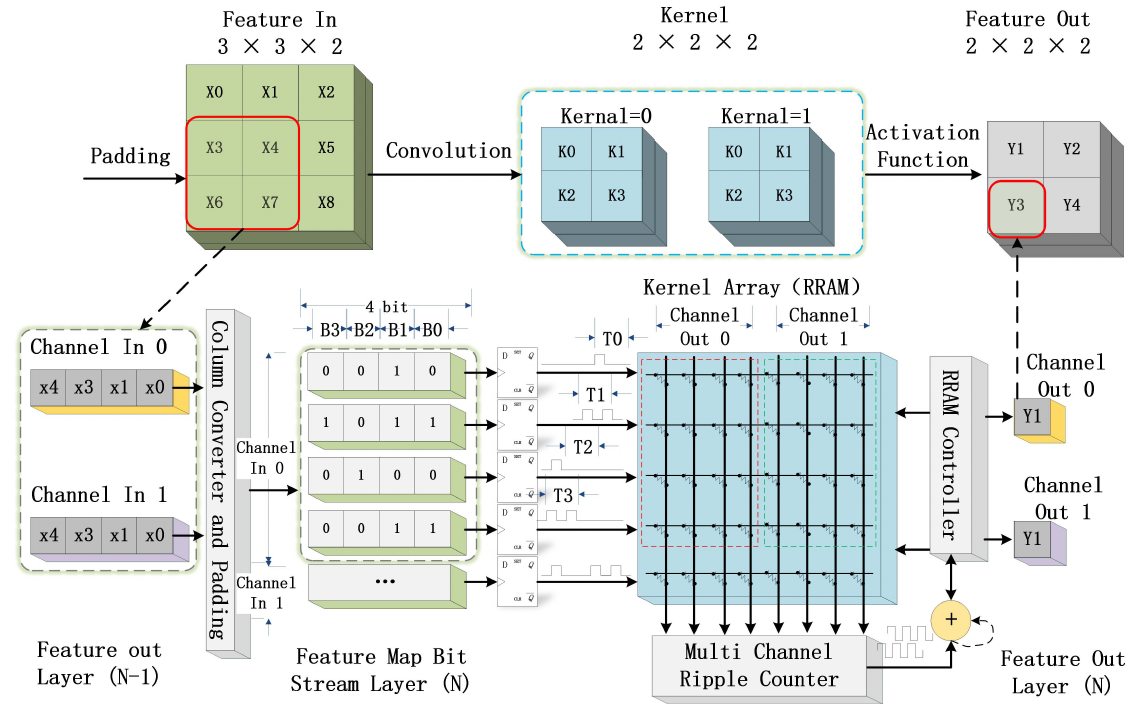
Figure 5. Illustration of data flow in the proposed RRAM PIM